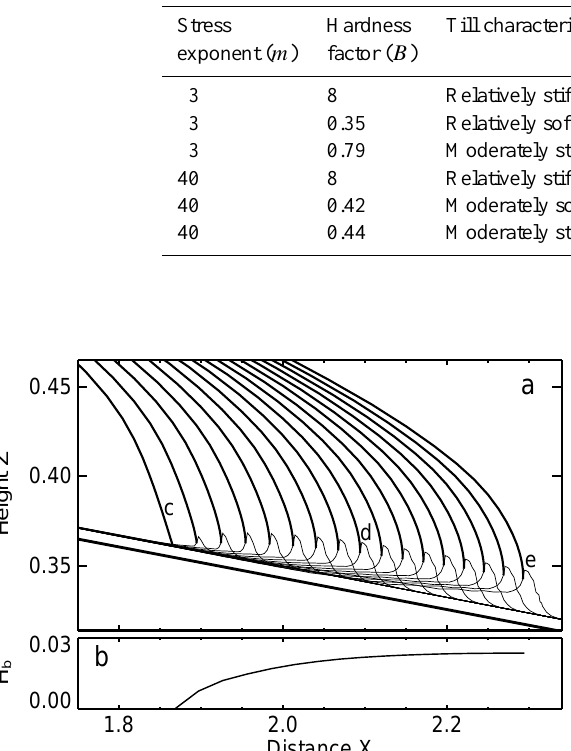
Table 1. Flow parameters used in the sediment layer for the different experiments.